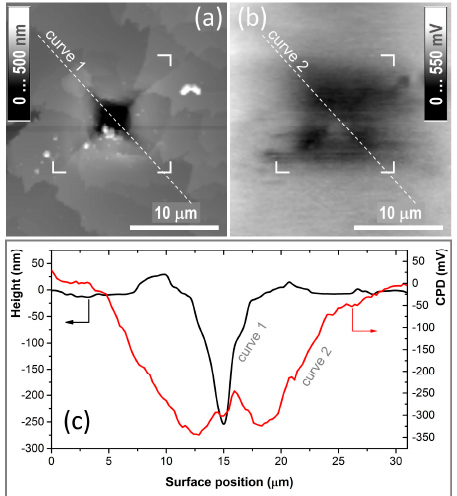
Figure 3. ( a ) Topography and ( b ) corresponding tip-surface CPD maps for the indent in diamond shown in Figure 1. ( c ) Cross-sections of maps along the same line on surface: relief profile (curve 1) and CPD profile (curve 2). Corner-like marks are shown to compare areas of low CPD and the indent area.